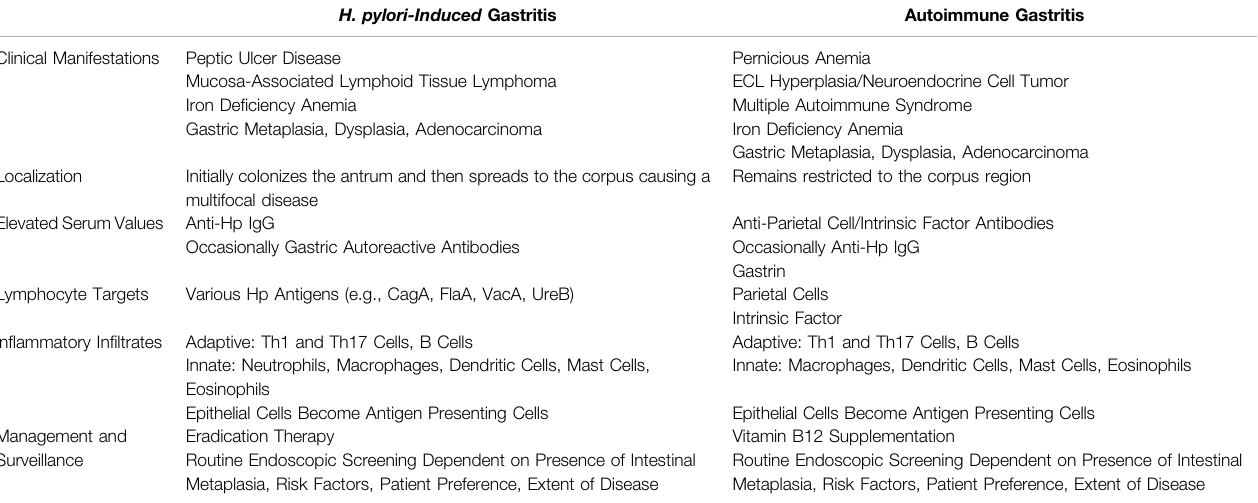
TABLE 1 | A visual overview comparing infection and autoimmunity induced